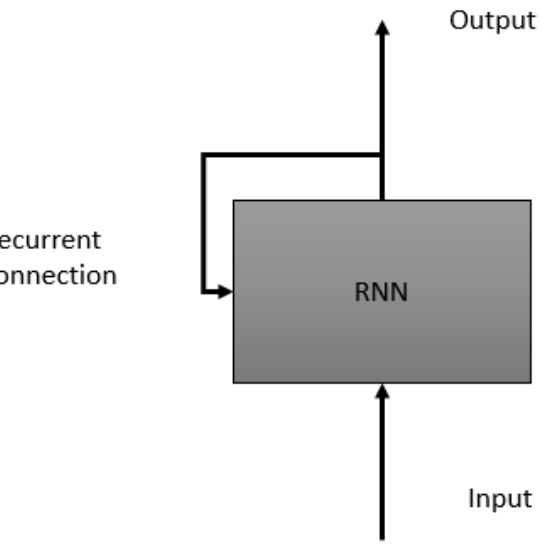
Figure 11. Concept of Recurrent Neural